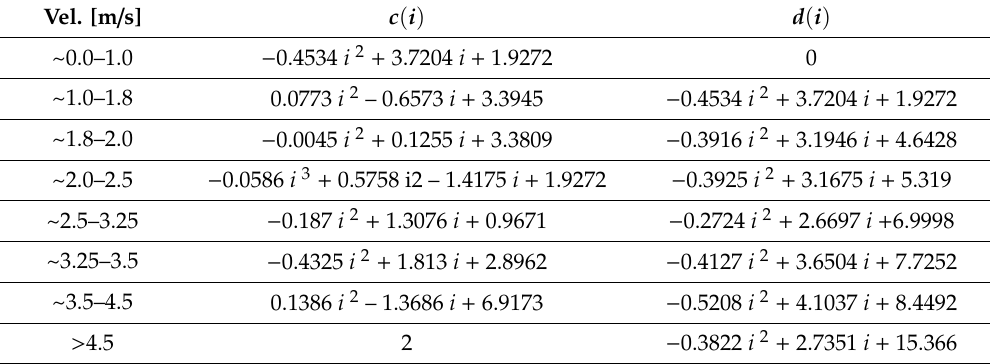
( b ) Figure 11. Estimation results of F-V model for MR damper : ( a ) Comparison results between experimental and simulator results; ( b ) Simulation F-V curve according to continuous current inputs. 3. Waveform Prediction Simulator